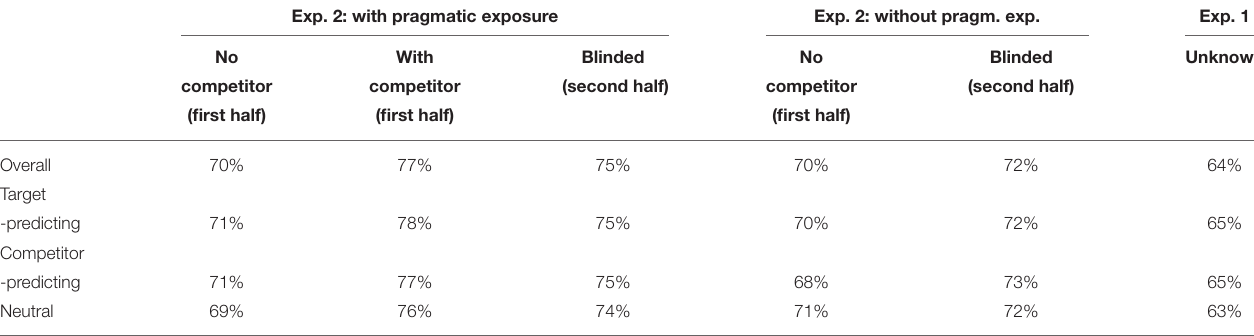
TABLE 8 | Mean unambiguous DC proportion per participant under various conditions in Experiment 1 and 2. Exp. 2: with pragmatic exposure Exp. 2: without pragm. exp. Exp. 1